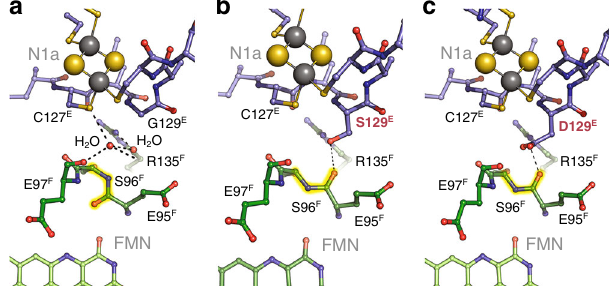
Fig. 4 Mutagenesis of G129 E in fl uencing the orientation of the peptide bond between E95 F and S96 F . a In the oxidized form of original NuoEF, the absence of a side chain in amino acid G129 E generates a cavity that harbors two water molecules. The peptide carbonyl of residue E95 F points toward the substrate binding pocket. b In the oxidized form of the G129S E variant, the serine side chain replaces the water molecules, but the peptide bond at E95 F is fl ipped. The 3.5 Å distance between the hydroxyl group of the serine residue and the carbonyl oxygen indicates a weak hydrogen bond. c The even larger side chain in the G129D F variant has the same effect as in ( b ), but here a stronger H-bond to the fl ipping peptide carbonyl of 3.2 Å lengths is formed, locking the structure in this con fi guration. In essence, the oxidized states of the two variants attain a conformation at E95 F that in the original protein is only found in the reduced Gly/Ser mutation. The same position of the peptide bond was retained when the oxidized G129D E variant was soaked with NAD + . However, no electron density for the nicotinamide ring and its ribose is detected, while the ADP moiety is well de fi ned. Thus, the nicotinamide might adopt several positions within the